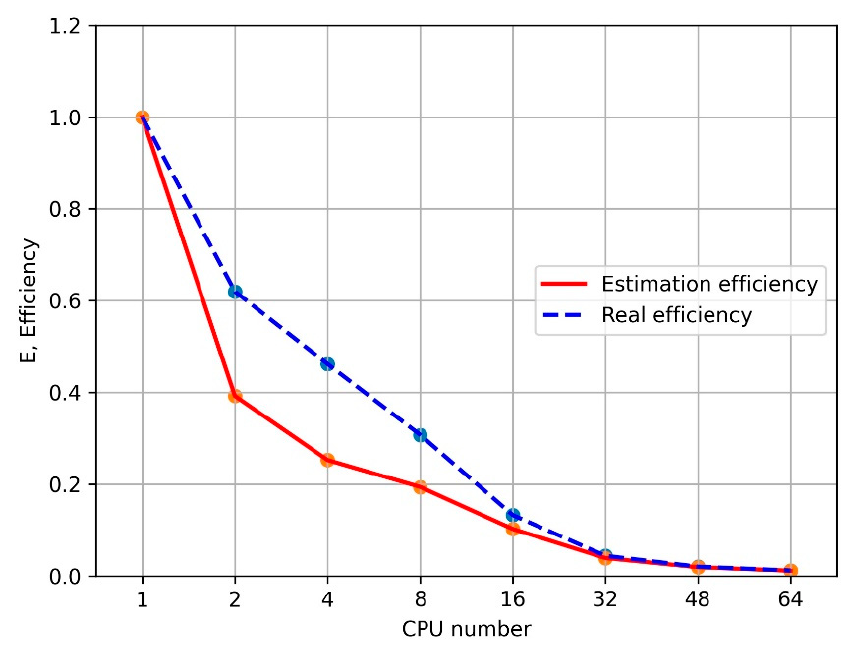
Figure 5. The efficiency of parallel implementation for the first block of calculations. Figure 6 shows how the efficiency of a parallel program depends on the number of processes involved in the calculation for the second computational block.